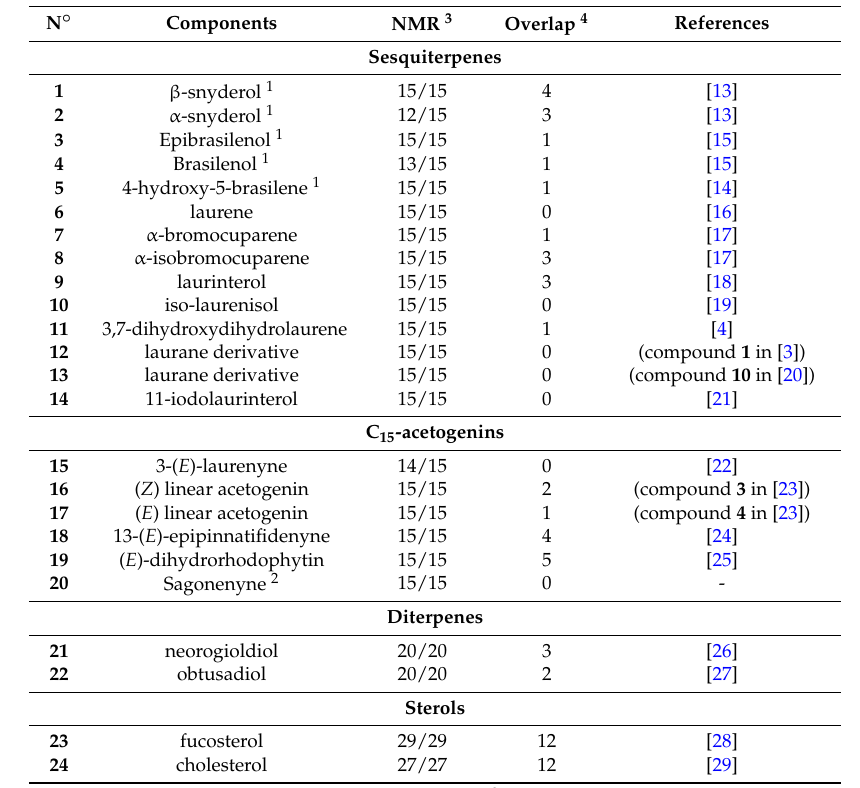
Table 2. Compounds identified in Laurencia obtusa